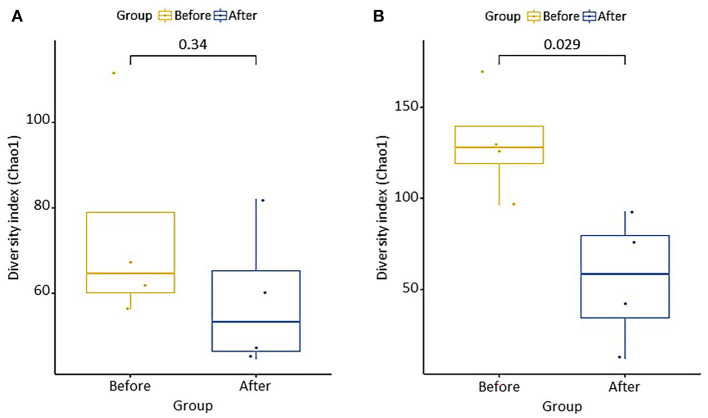
Chao1 richness boxplot showing difference of (A) bacterial and (B) fungal microbial communities before and after fermentation. Group difference was determined Wilcoxon rank-sum test.